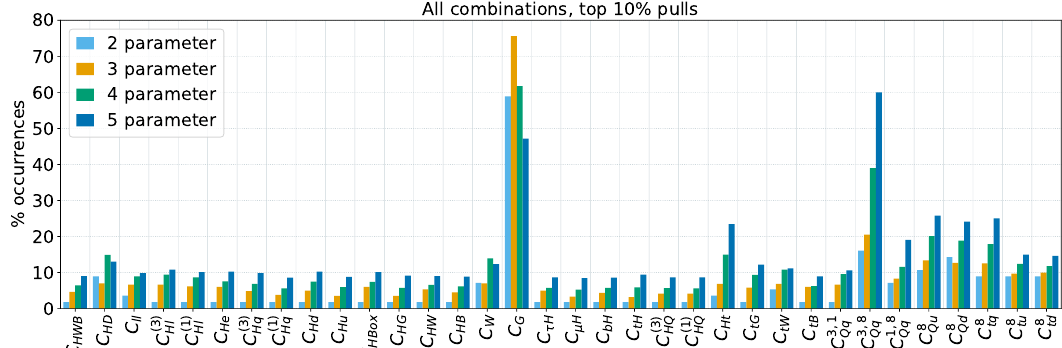
Figure 19 . The percentage occurrence of a given operator in the combinations ranked in the top 10% of pulls found in fits to 2 (light blue), 3 (orange), 4 (green) and 5 (blue) parameter